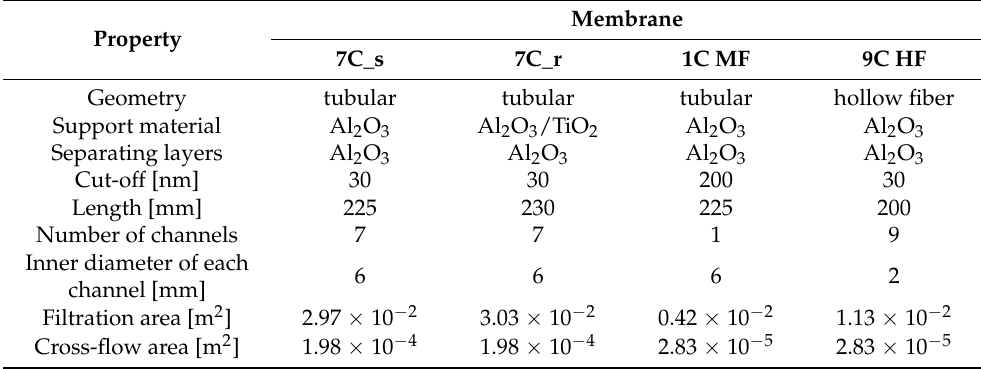
Table 1. Properties of the ceramic membrane used in this